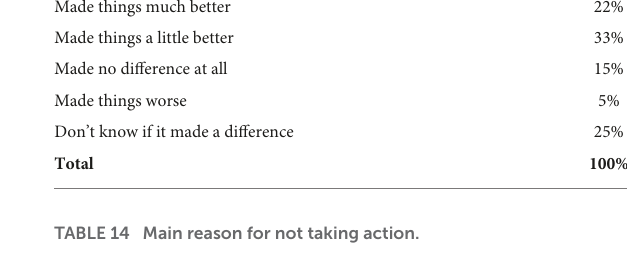
TABLE 12 Main reason for taking action.